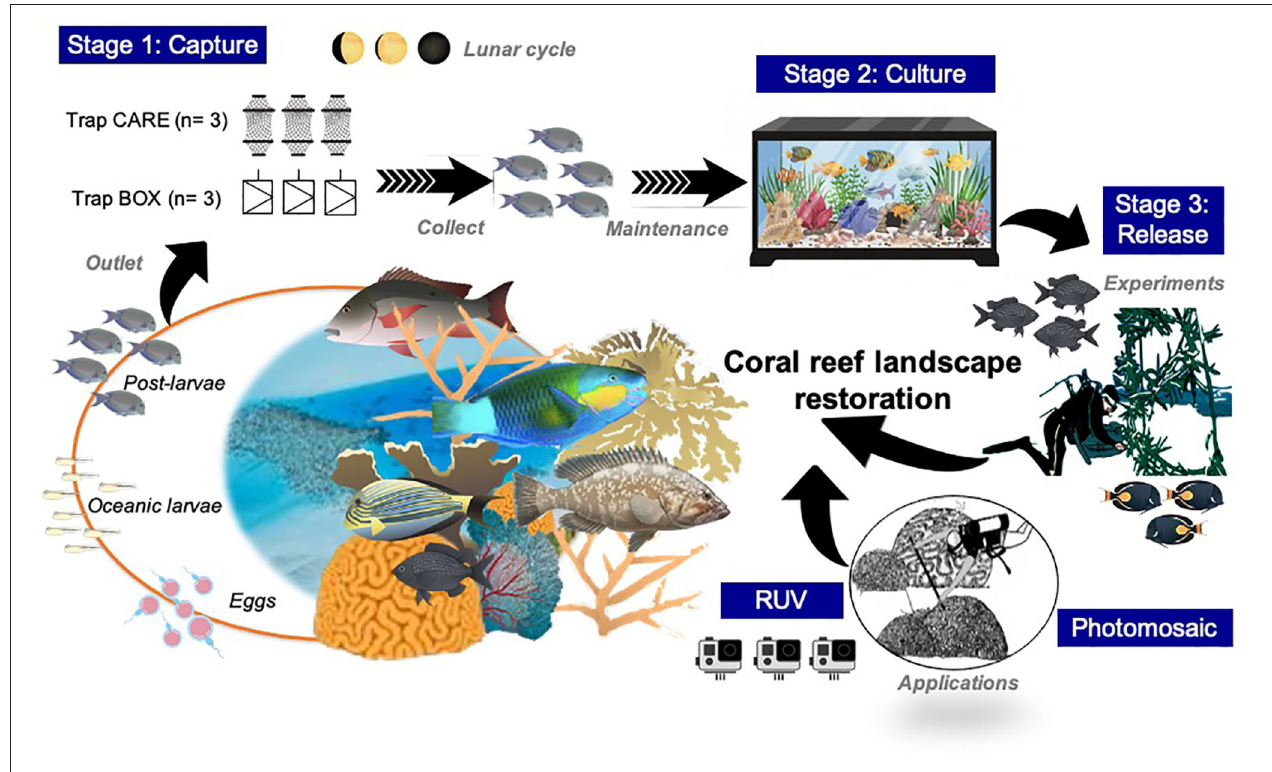
FIGURE 1 | General outline process for scaling up restoration of coral reef using oostlarval reef fishes: capture, culture, and release.